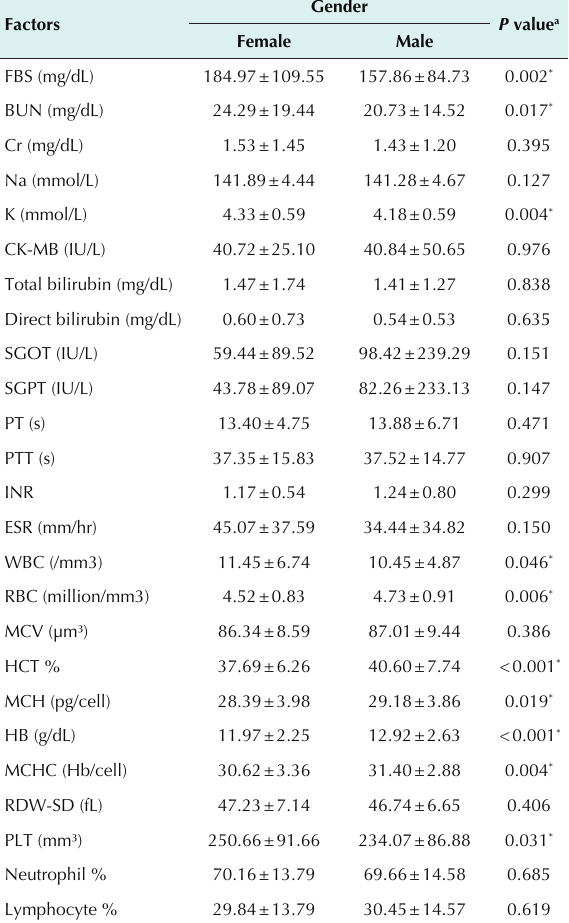
Table 3. Mean and Standard Deviation of Factors Studied in Patients With Cardiovascular Diseases by Gender Factors